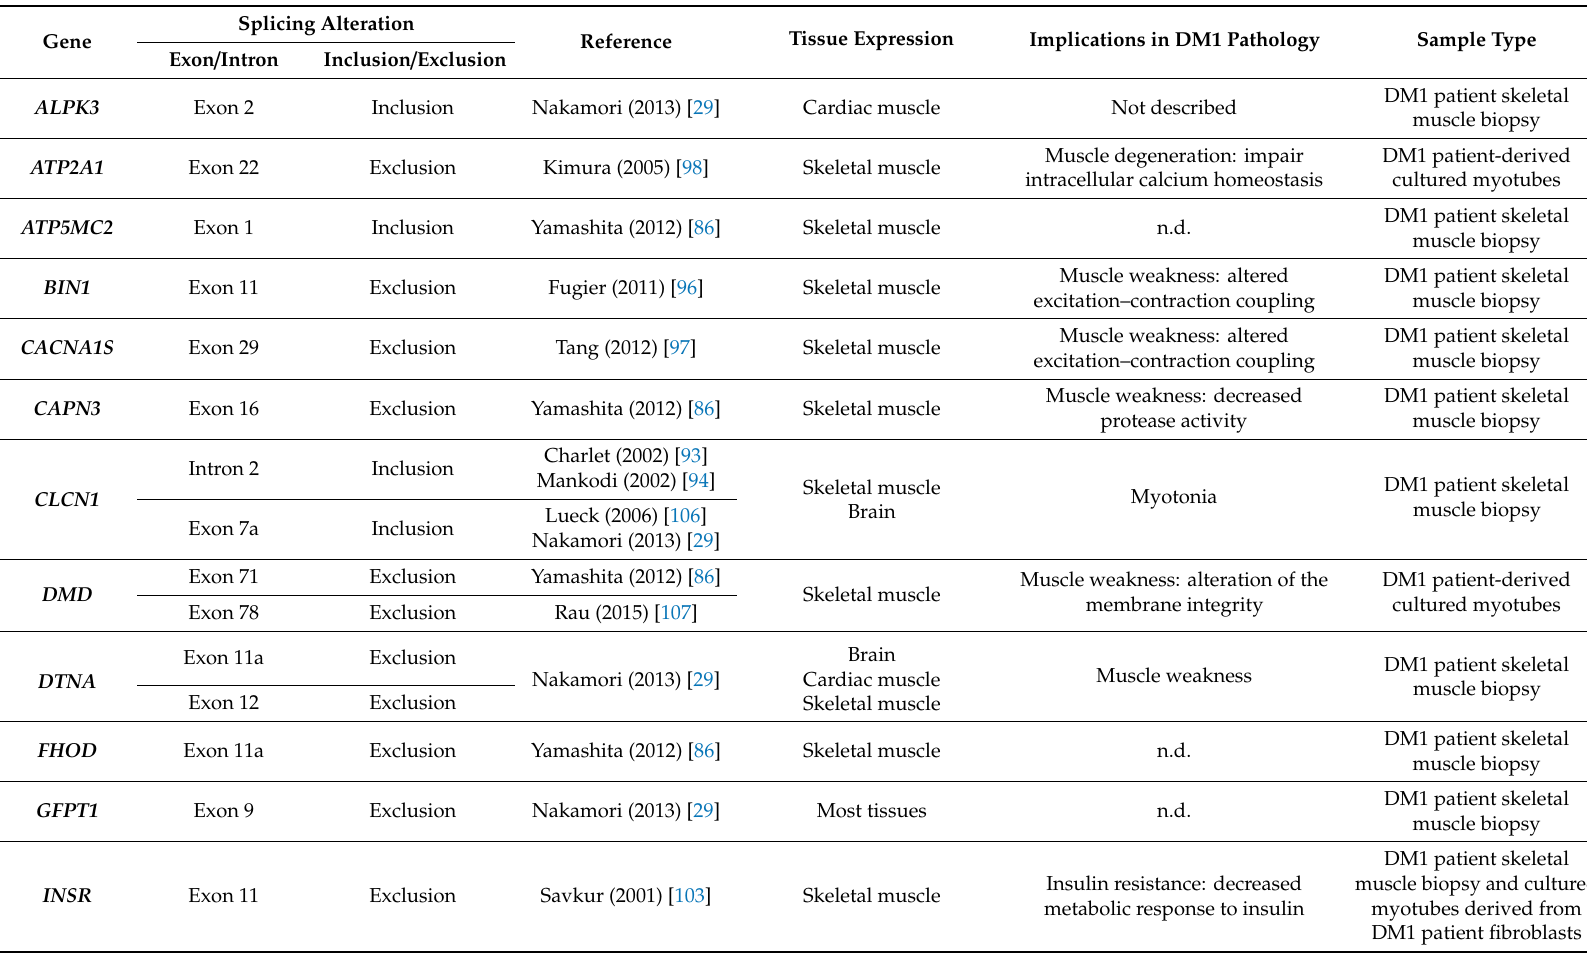
Table 2. Summary of transcripts expressed in skeletal muscle altered in DM1 samples. All genes mentioned are described in the text and represented in